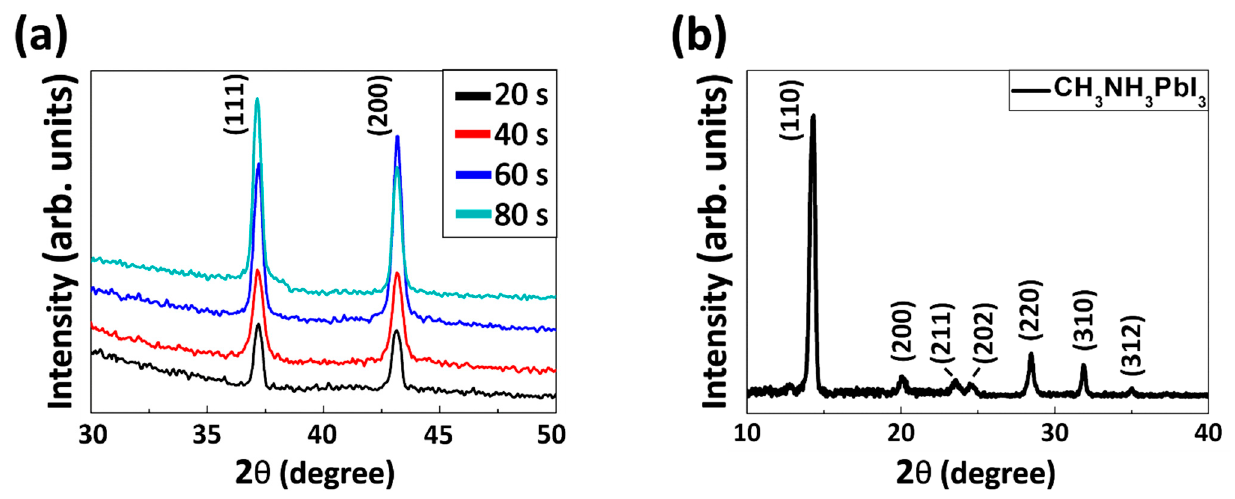
Figure 3. The XRD diffraction patterns show: ( a ) NiO x hole transport layers deposited times for 20 s, 40 s, 60 s, and 80 s, respectively. All NiO x films were annealed at 500 ◦ C for 1 h; ( b ) the XRD diffraction peak of a CH 3 NH 3 PbI 3 perovskite film.